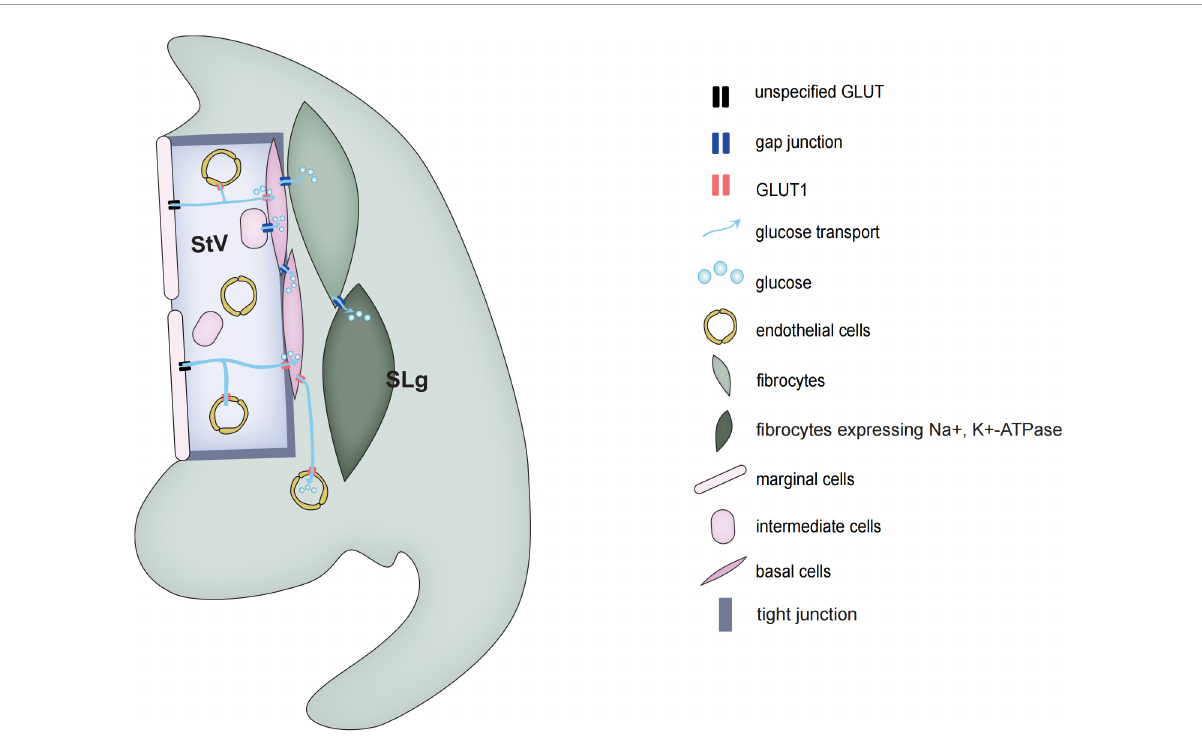
FIGURE2 Schematic diagrams of glucose transport in the stria vascularis and spiral ligament of the